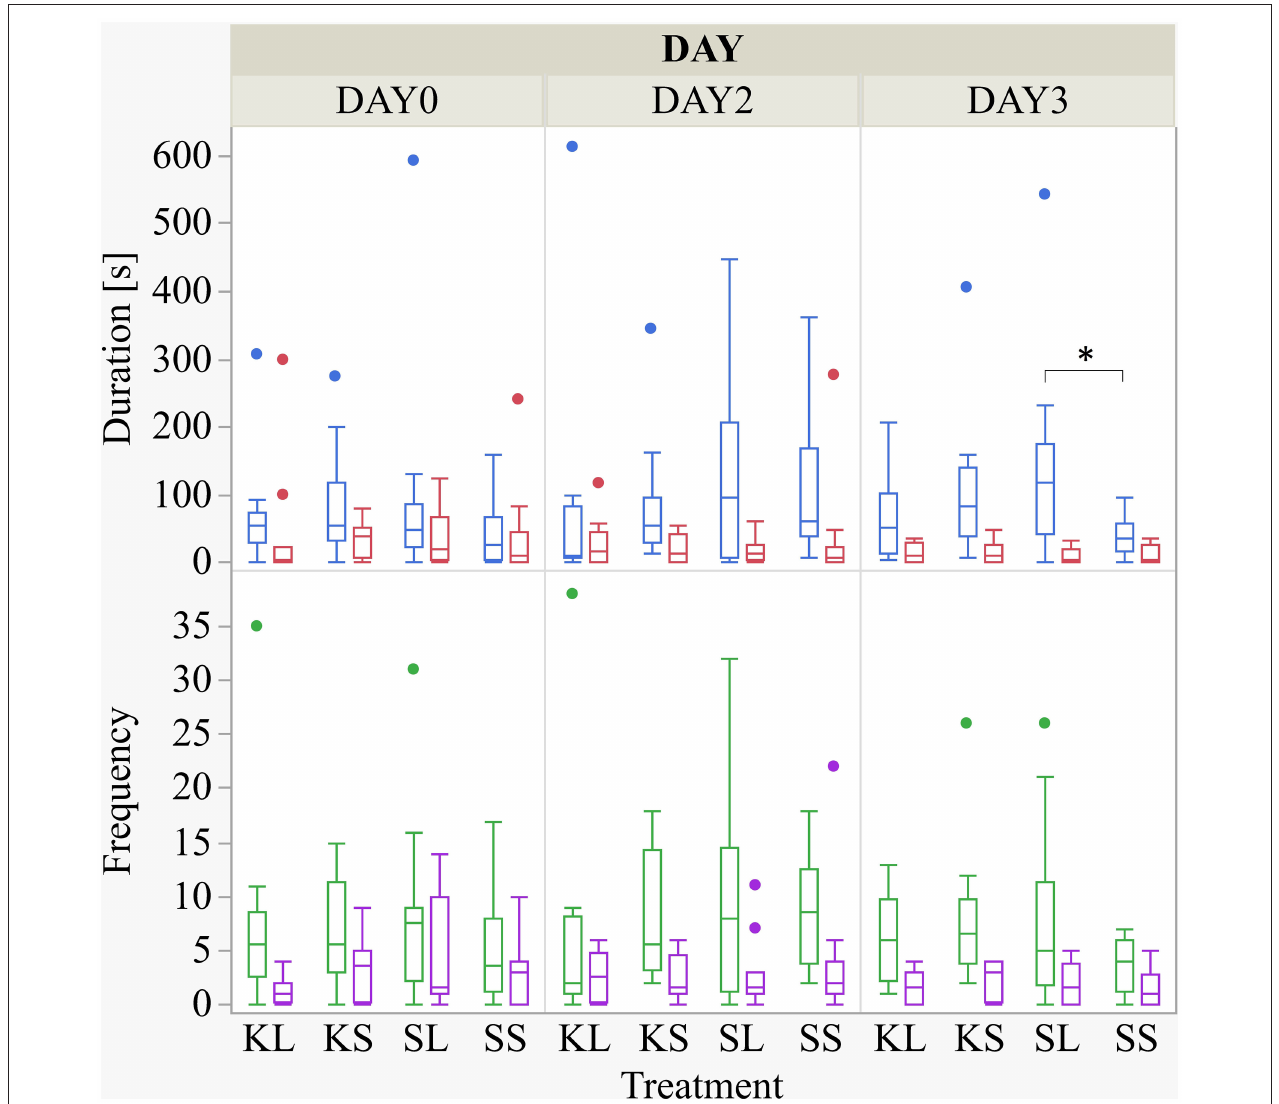
FIGURE 2 | Duration (s) and frequency of performed ear manipulation (blue and green boxplot, respectively) and tail manipulation (red and lilac) at baseline (DAY0) and at the first (DAY2) and second day (DAY3) after injecting the pigs with ketoprofen–lipopolysaccharide (LPS), ketoprofen–saline, saline–LPS, and saline–saline. Round dots indicate outliers. Significant differences of planned comparisons between treatments ( p < 0.05) are marked with an